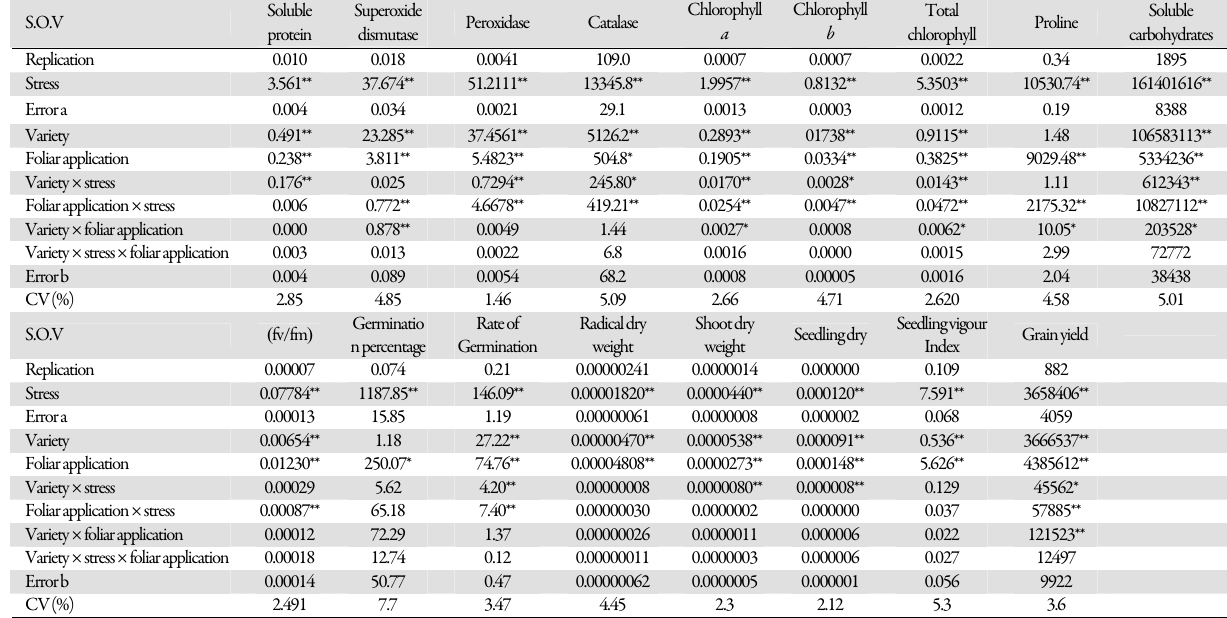
Table. 1. Analysis of variance on yield, physiological traits and seed vigor of two soybean cultivars S.O.V Replication Error a Variety